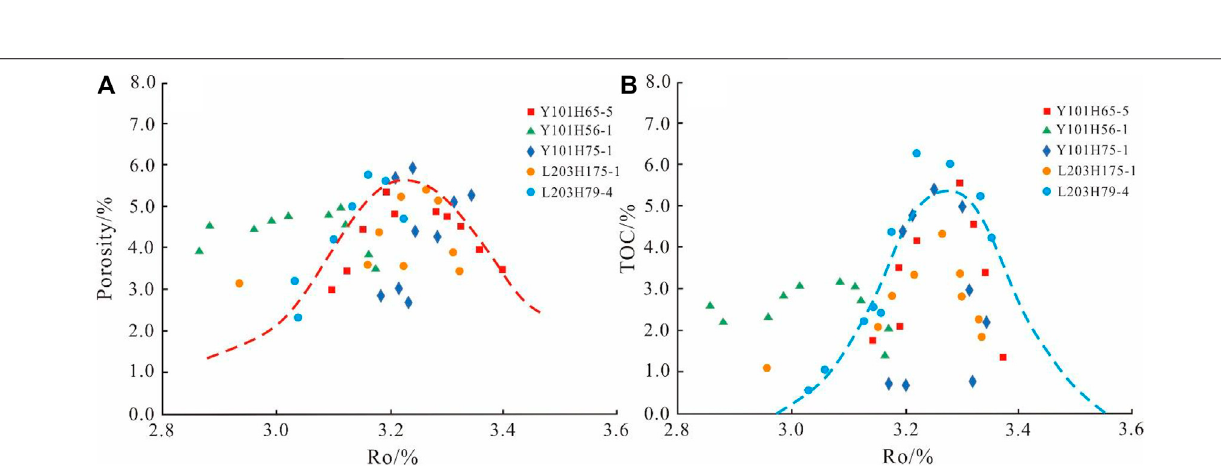
FIGURE 10 | Comprehensive model of burial history, hydrocarbon generation and structural evolution of shale in the Longmaxi formation encountered in typical wells in the Luzhou area. (A) . Well Y101H65-5; (B) . Well L205; (C) . Well 201.